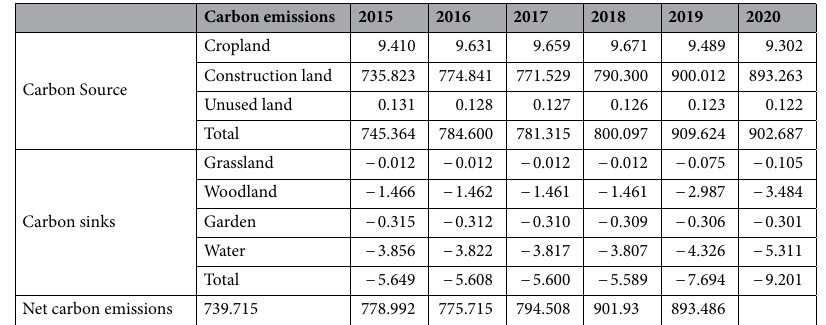
Table 6. Estimates of carbon emissions from land use in the Yellow River Delta 2015–2020 (ten thousand tons).